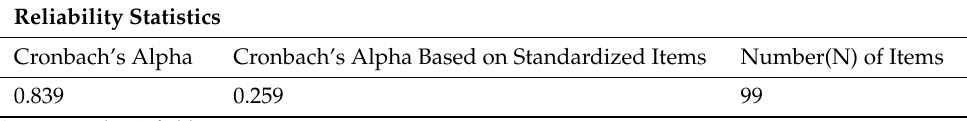
Table 2. Cronbach alpha test statistics on research